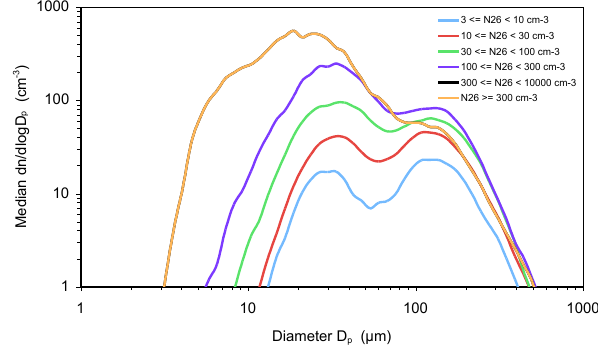
Fig. 7. Median number size distributions fitted with lognormal func- tions in six sub-populations, in which the concentrations of ultrafine particles was varied between 0 and > 300cm − 3